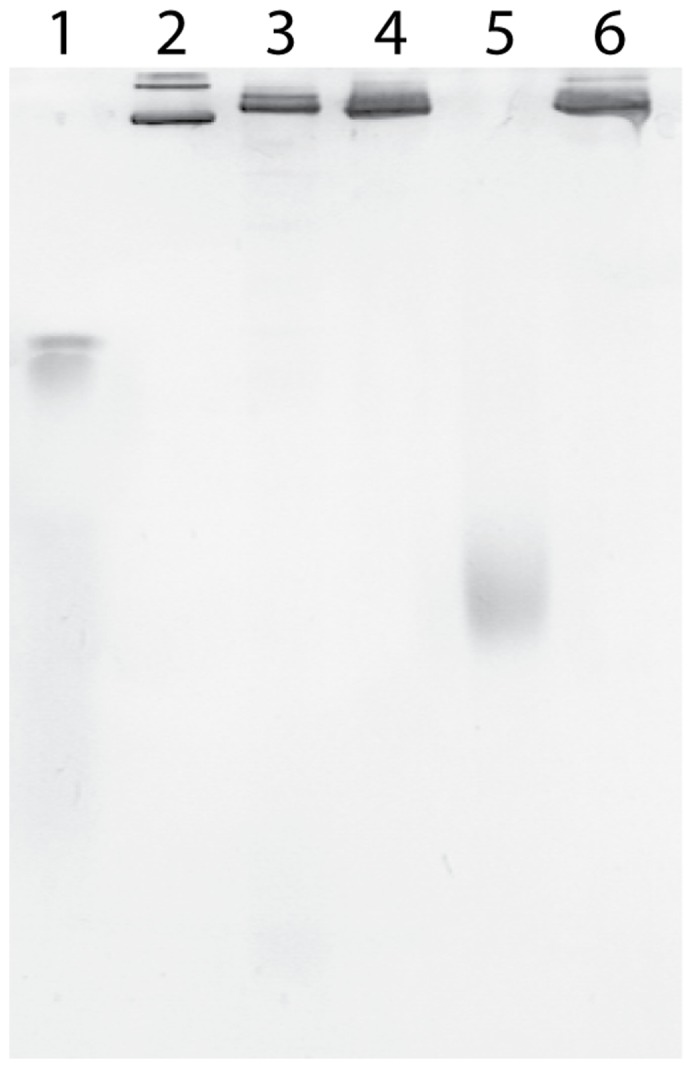
BN-PAGE analysis of purified complex II from T. thermophilus.
Lanes: 1– β-amylase (200 kDa), 2– apoferritin monomer (443 kDa) and dimer (886 kDa), 3– native complex II from T. thermophilus, 4– wt-rcII, 5– rcII-SdhB-His6, 6– rcII-His8-SdhB.